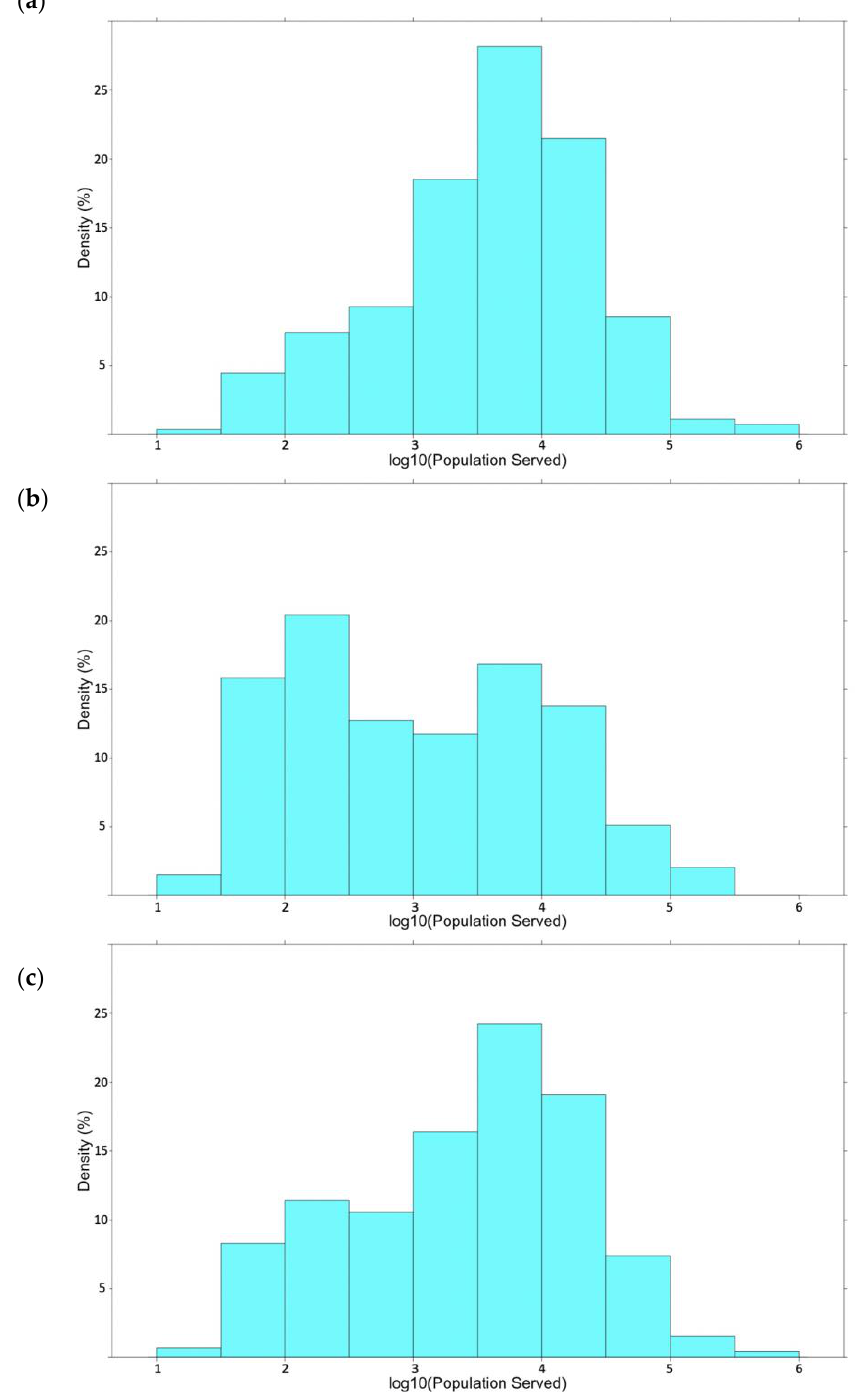
Figure 5. log10 (population) distributions of ( a ) the systems having punctuated changes when MCL lowered from 50% to 49%; ( b ) the complement of systems in part 1 (systems did not have punctuated changes); ( c ) all systems.